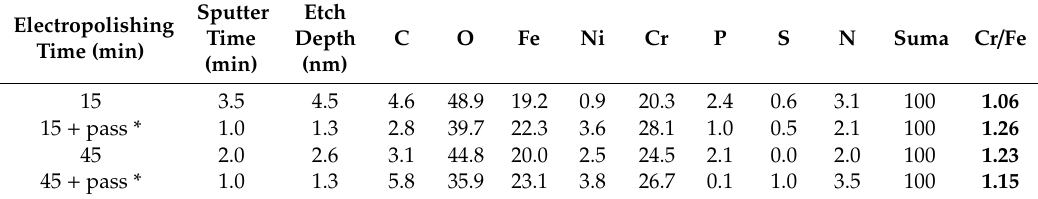
Table 2. Atomic percentages as a function of sputter depth for the passive films on a 304 stainless steel samples.